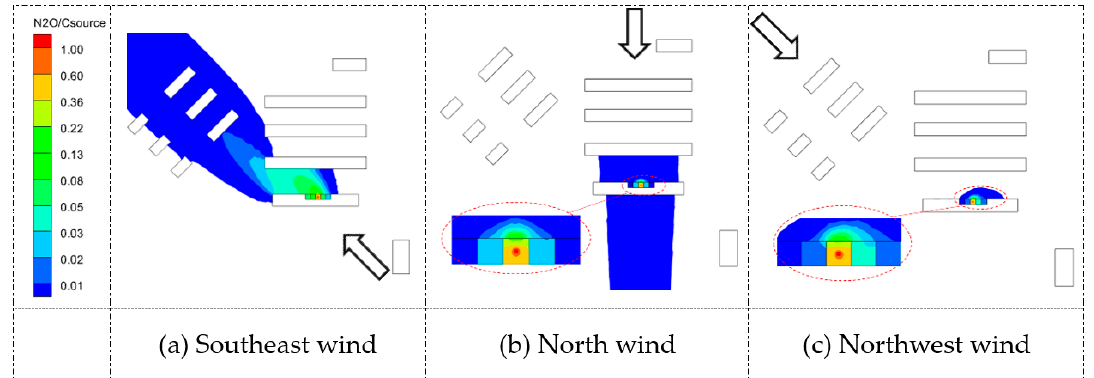
Figure 9. Comparisons of nondimensional concentration fields on horizontal plane Z = 0.46 m under three wind directions for Q1 source building. Arrows represent three different wind directions.